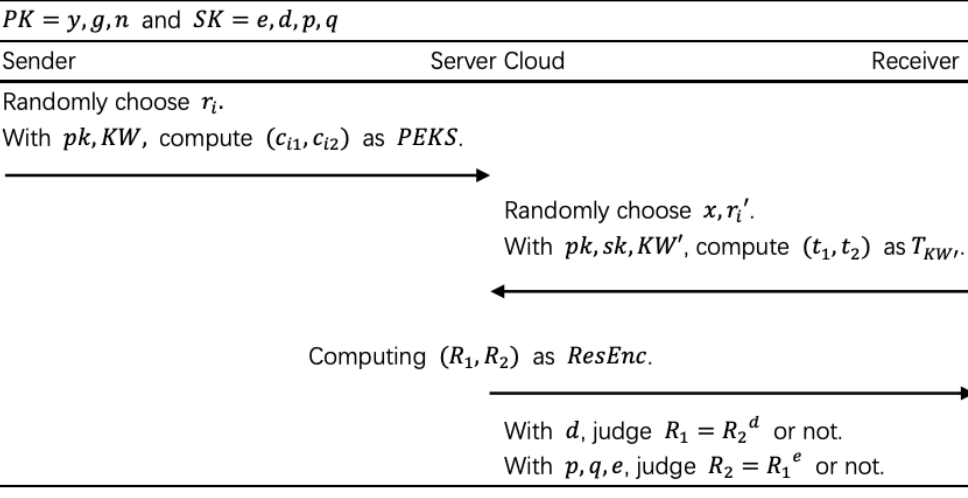
Figure 4. Flow of